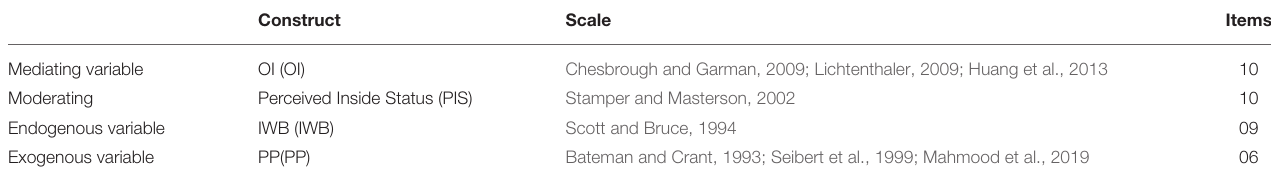
TABLE 2 | Measures of the